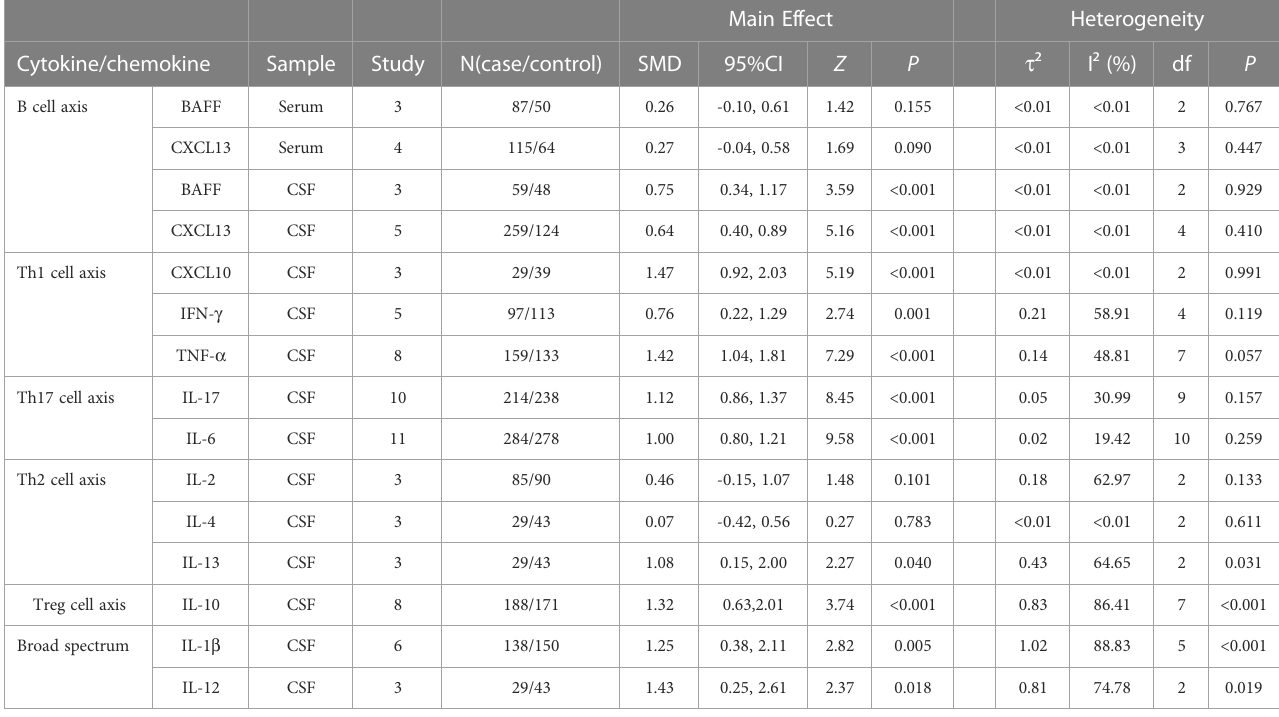
TABLE 1 Summary of the meta-analysis outcomes for the different